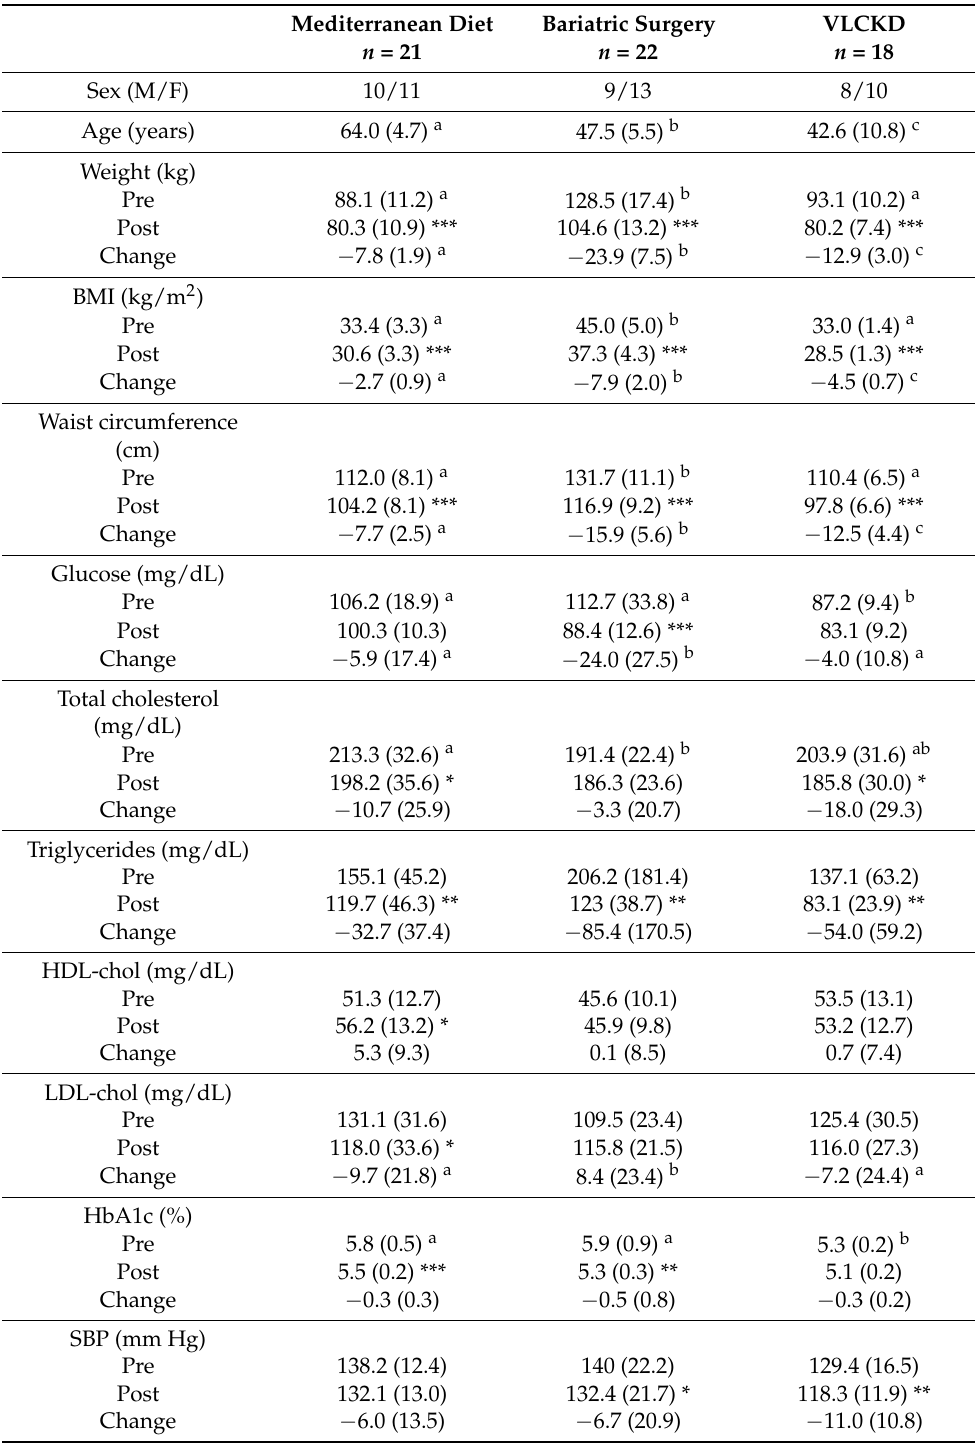
Table 1. Anthropometric and biochemical